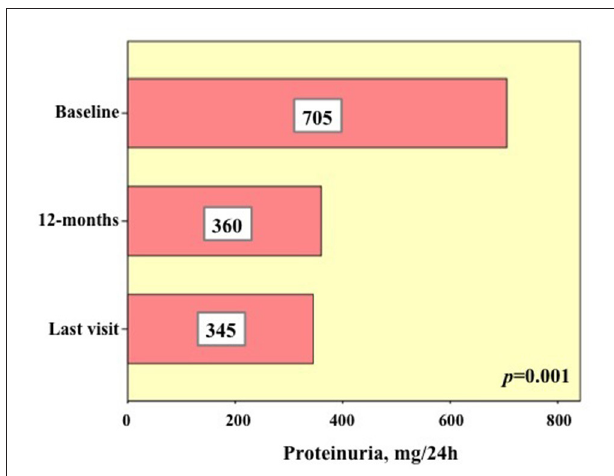
FIGURE 3 | Details about 24h proteinuria in six patients (eight biologic courses) presenting with pathologic proteinuria (i.e., > 150 mg/24h) at the start of biologic treatments (baseline), after 12 months and at the last assessment. The numbers added in the histograms indicate the median of the 24h proteinuria values found in the eight biologic courses at the three